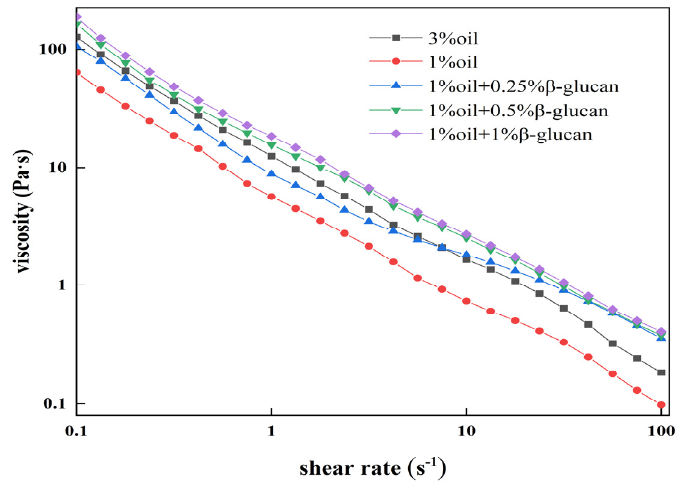
Figure 3. The viscosity of low-fat pea-protein-based yogurt versus shear rate as a function of oat β -glucan concentration.